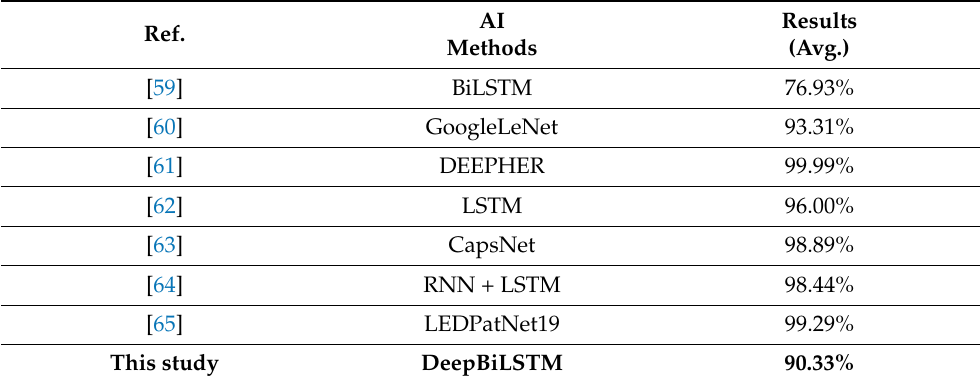
Table 5. Comparison of the designed deep learning model with other deep learning models.